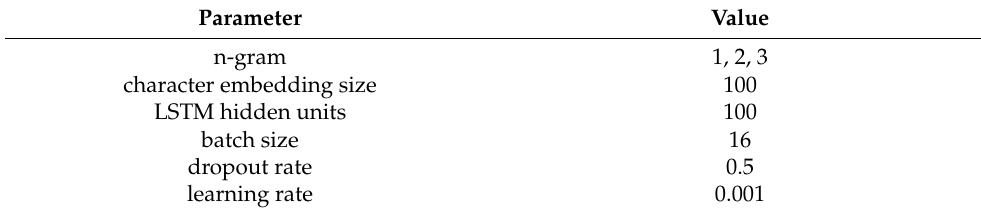
Table 3. Hyper-parameter settings of the proposed approach. Parameter Value